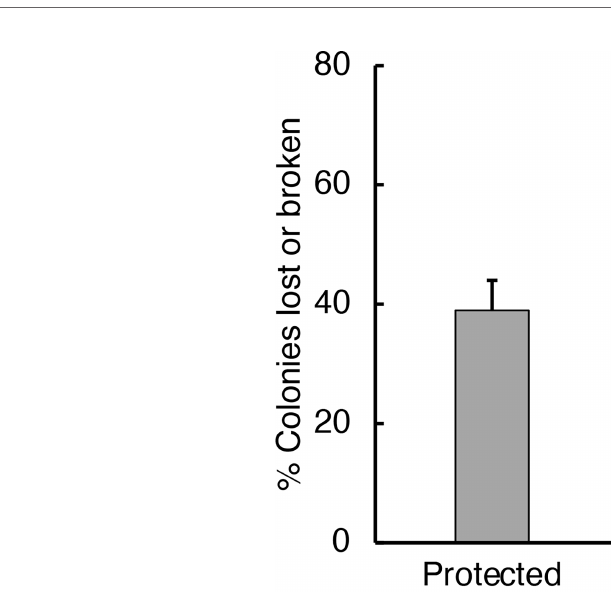
FIGURE 11 | Percent of the colonies of M. membranacea on M. splendens (collected from the protected site) that were lost or broken over a 24-hour period after the algae were attached to tires at the protected site (grey bar) or at the exposed site (black bar). A signi fi cantly greater percentage of the bryozoan colonies were damaged or lost at the exposed site than at the protected site (p < 0.05, one-way ANOVA followed by Tukey HSD test, F= 6.25 1,9